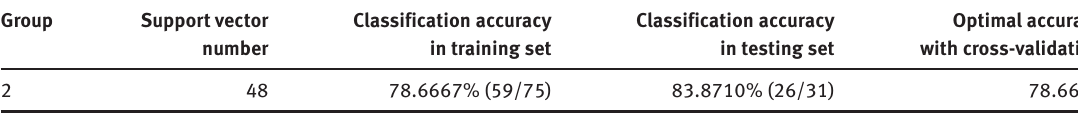
Table 5: The Classification Accuracy in the Second Group of Experimental Model.